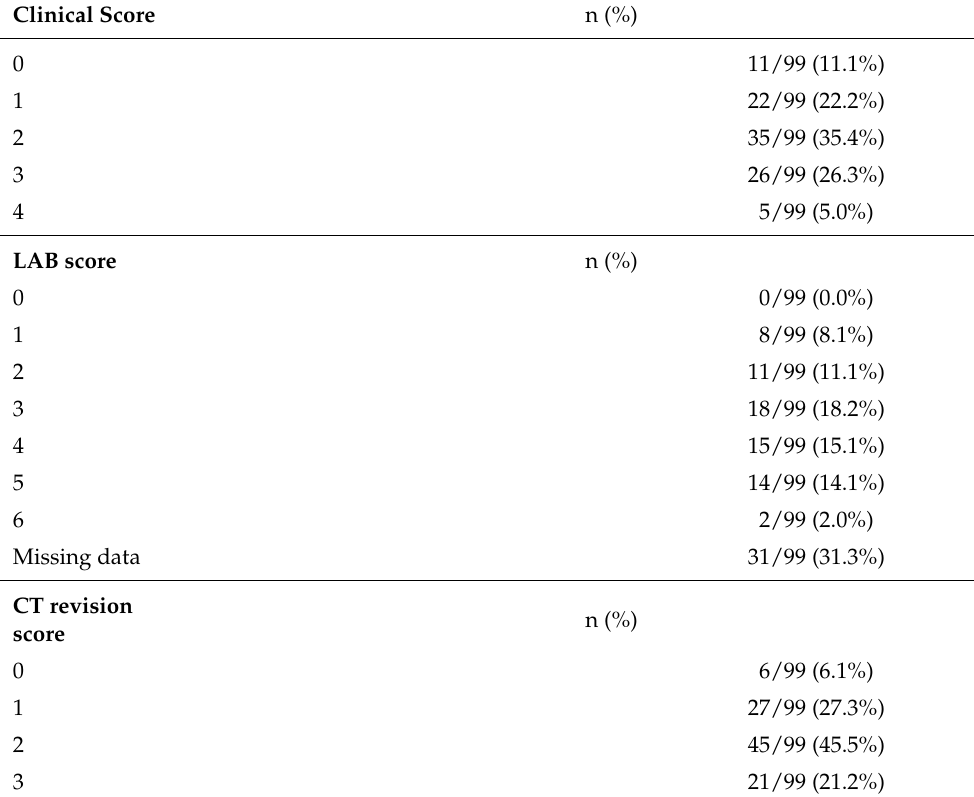
Table 2. Clinical, LAB and radiological score distribution in the study